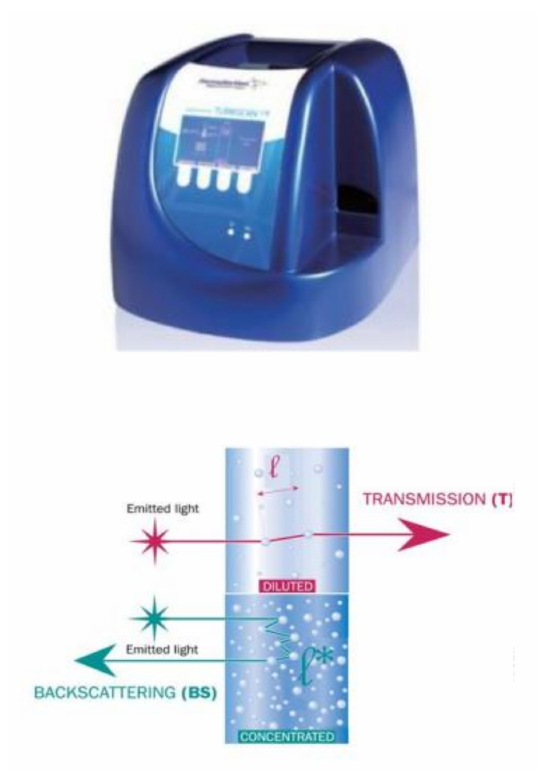
Figure 3. Physical map and schematic diagram of the TURBISCAN Lab Expert stability